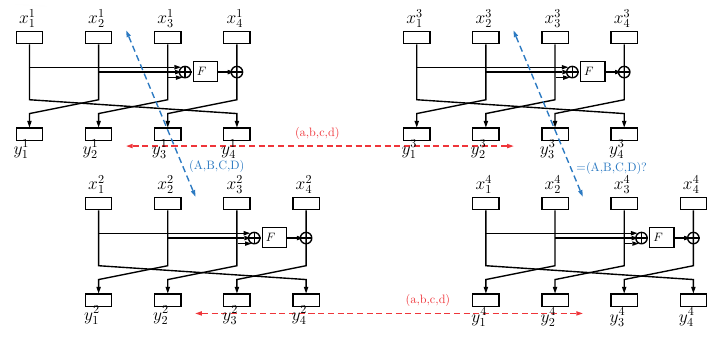
Figure 11: Boomerang switch over one round of the source-heavy